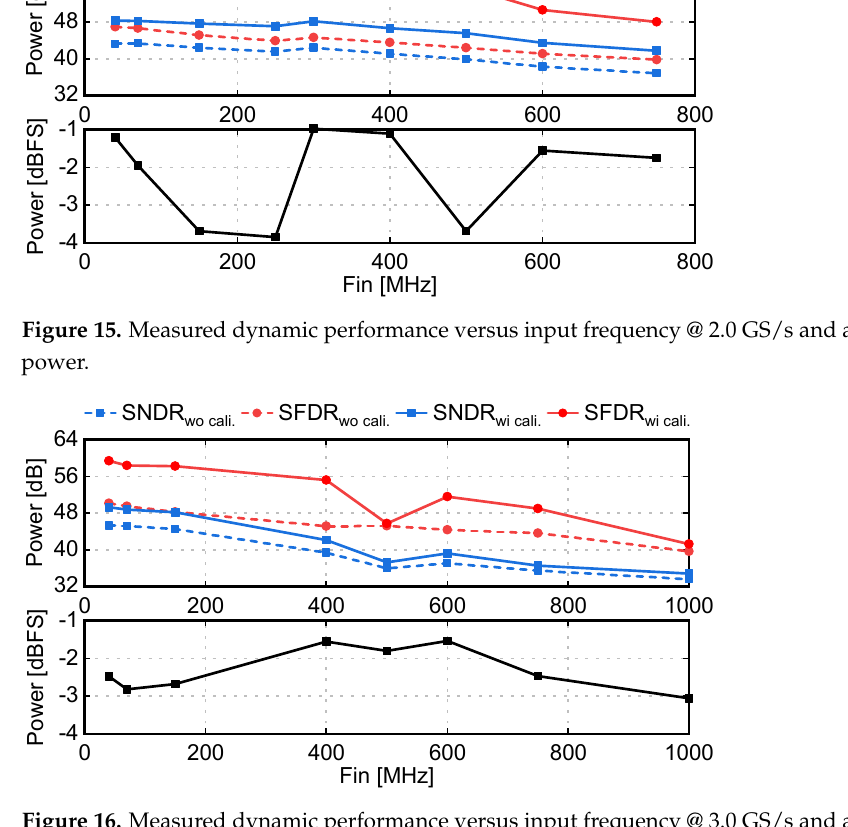
Figure 16. Measured dynamic performance versus input frequency @ 3.0 GS/s and associated input power.